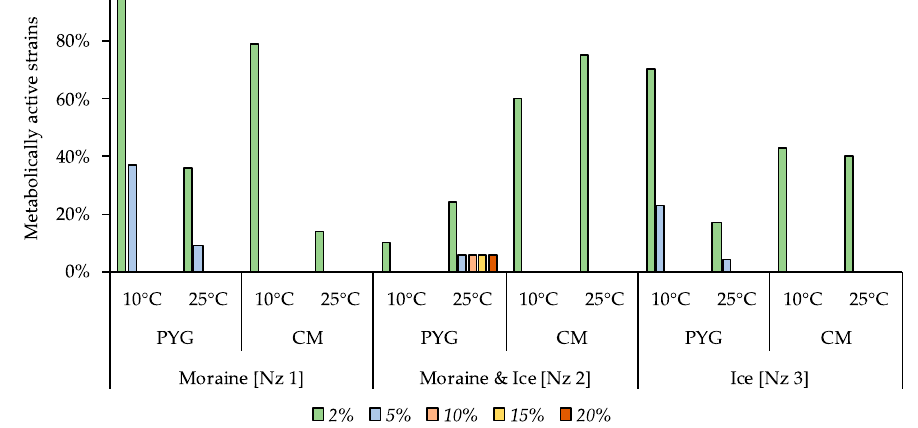
Figure 11. Isolated strains’ resistance to the presence of sodium bicarbonate in nutrient medium. Vertical axis: proportion of the strains in the culturable community able to reproduce in considered conditions. Horizontal axis: the tested communities. Temperature and medium abbreviations indicate the isolation conditions. PYG and CM—peptone yeast glucose and modified Czapek media, respectively.